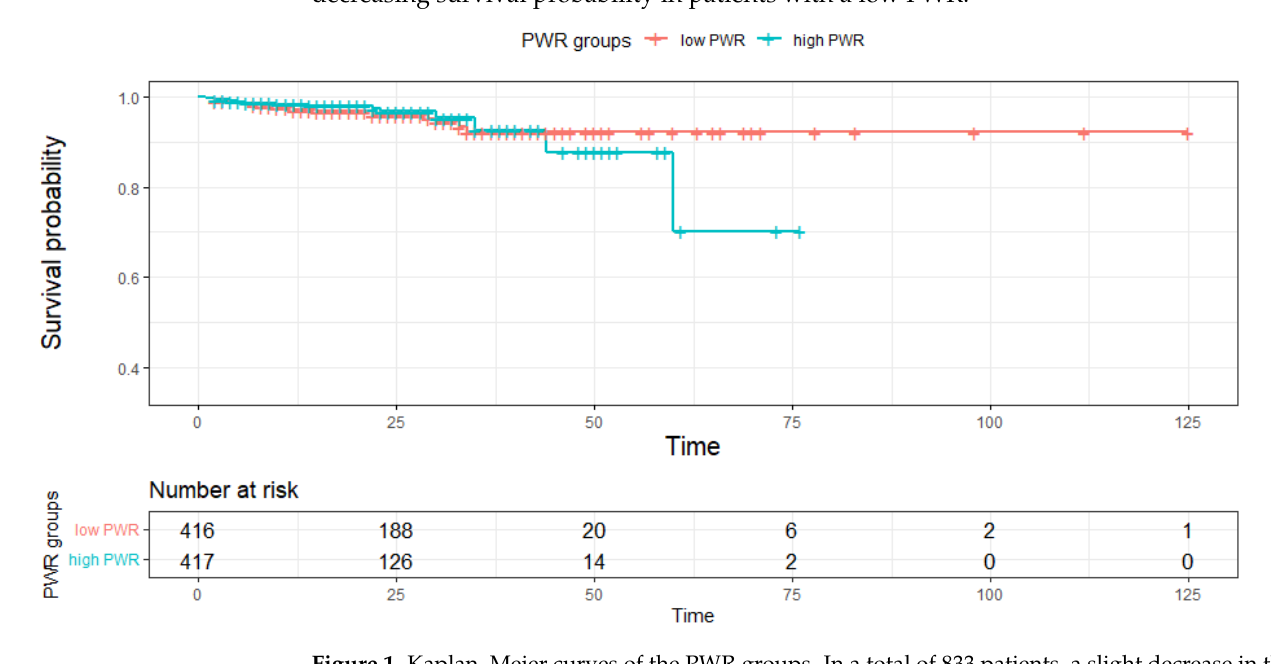
Figure 1. Kaplan–Meier curves of the PWR groups. In a total of 833 patients, a slight decrease in the overall mortality rate was observed, but the difference was not significant between the PWR groups. Patients were also stratified by the length of the hospital stay, and the results are compared to patients with a high PWR (hospital days (HD) 14 (80.5% vs. 63.1%, p = 0.001) and 28 (40% vs. 31.56%, p < 0.001)).